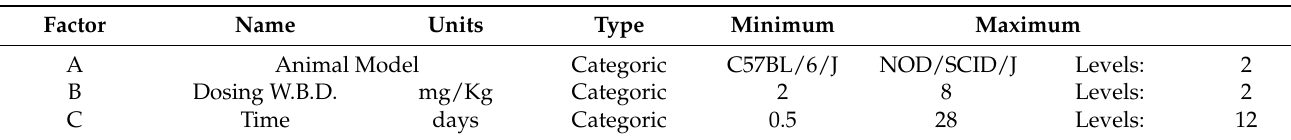
Table 2. Stratification of the animal model and dosing levels W.B.D. over time to search the design space for the opti- mum